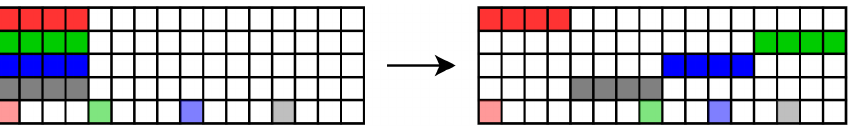
Figure 6. ShiftRows on the bitslice parity